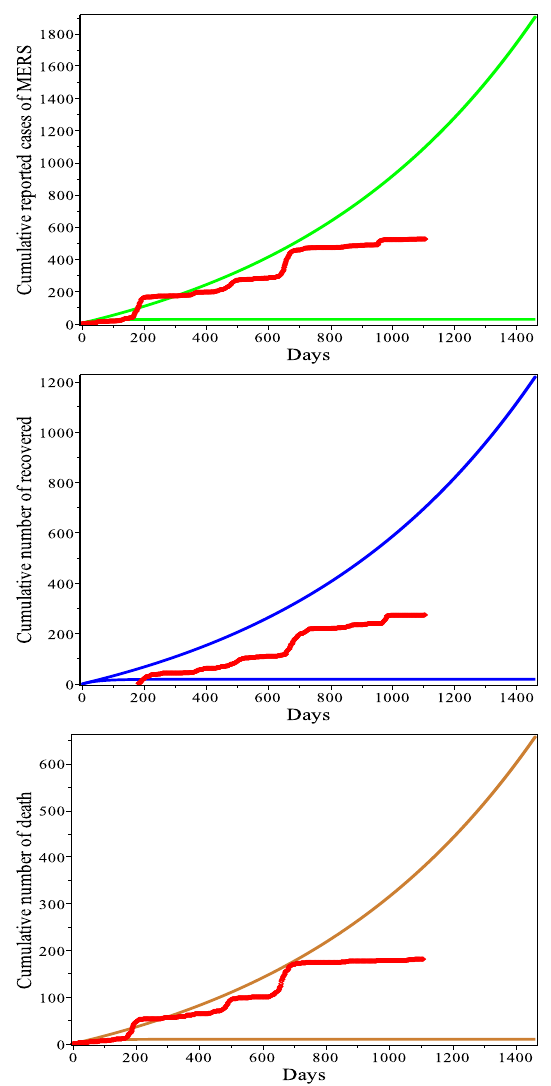
Fig. 6: Variations during the period of four years in cumulative reported cases of MERS (T), cu- mulative number of recovered (M), and cumula- tive number of deaths (B), as ω varies randomly annually in Ω β and so β varies in the interval [0 . 09 , 0 . 1241] .